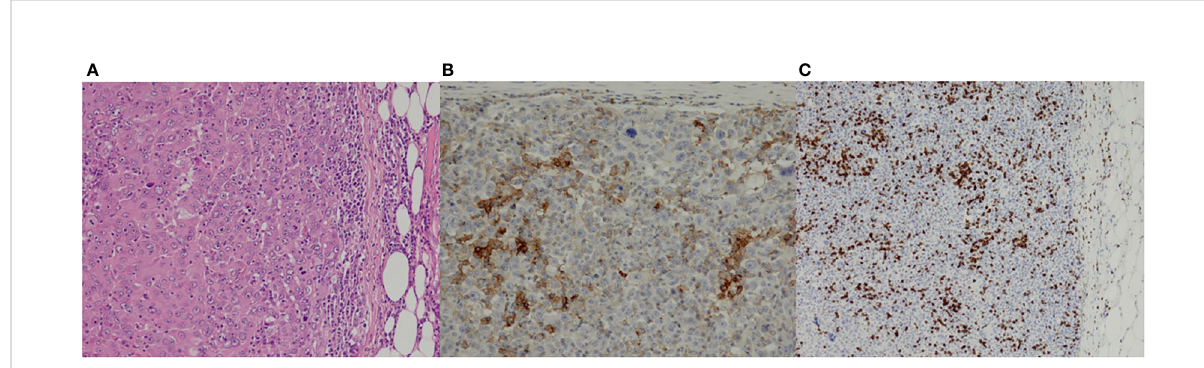
FIGURE 2 Pathological fi ndings of the primary cancer. Hematoxylin – eosin stain ( A ; ×10) showed the solid sheets and nests of large polygonal neoplastic epithelial cells with a paucity of stromal components. Immunostaining for PD-L1 ( B ; ×20) and CD3 ( C ; ×10) re fl ected the immunogenic properties of the